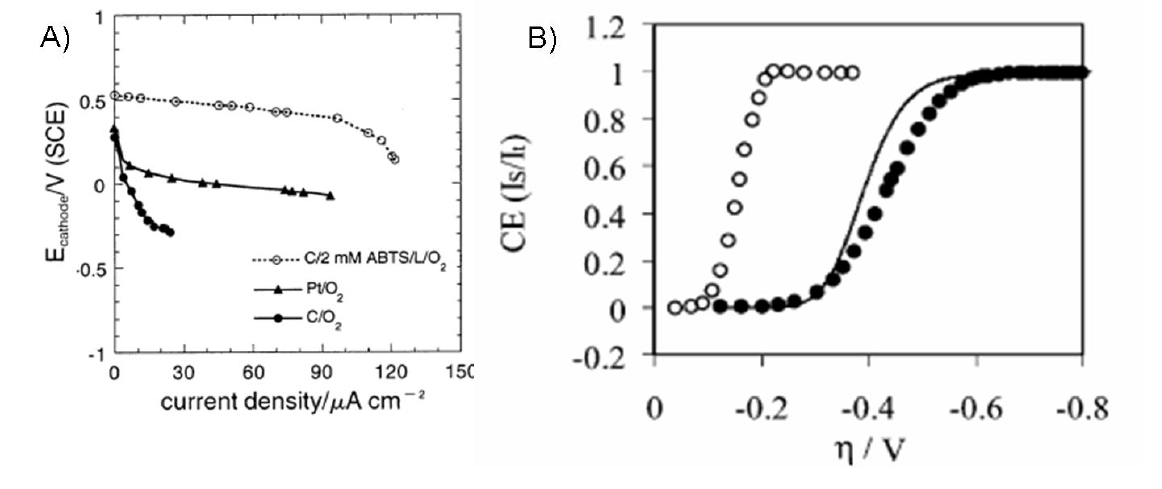
Figure 6. (A) Oxygen reduction by laccase biocathode compared to platinum and glassy-carbon cathodes. Reprinted from [17] with permission from Elsevier. (B) Dependence of the collection efficiency ( I generation-substrate collection mode SECM for Pt in 0.5 M H (full circles) and ―wired‖ BOD cathode (empty circles) at pH 7.2, 0.2 M phosphate buffer. Reprinted with permission from [96]. Copyright 2003 American Chemical Society.